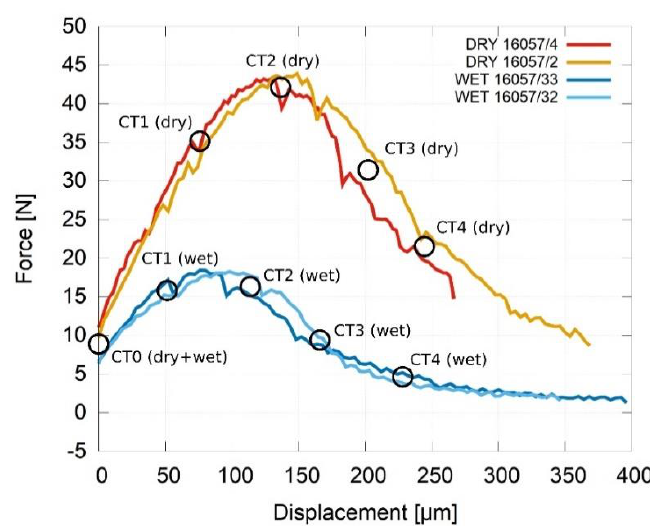
Figure 6. The force-displacement diagram showing the difference between the dry and the wet specimens and approximate locations of the CT scans.